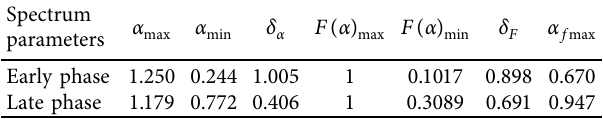
Table 4: Dimensions of multifractal global singular values and multifractal sets.